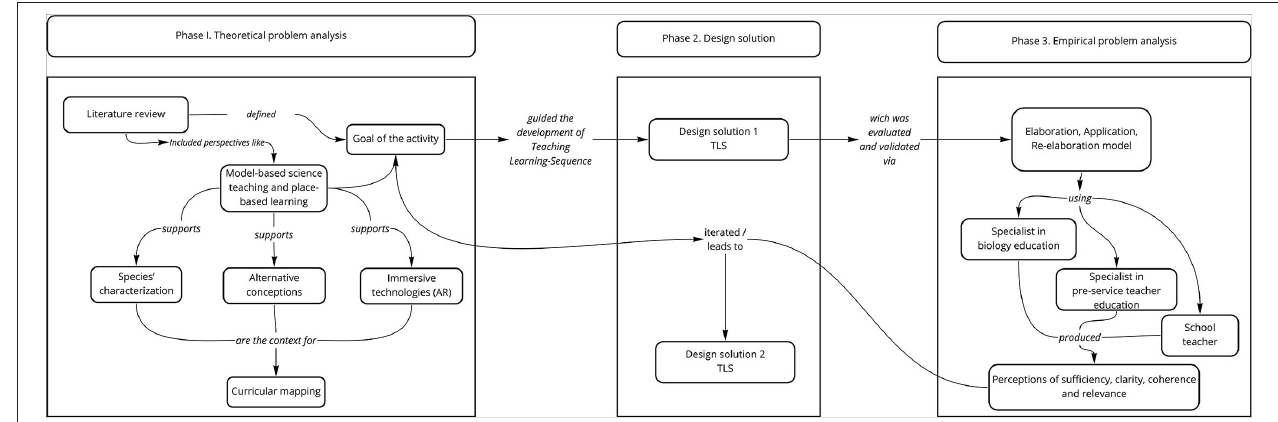
FIGURE 1 | DBR structure followed for the elaboration of the TLS (Adapted from Pernaa et al.,